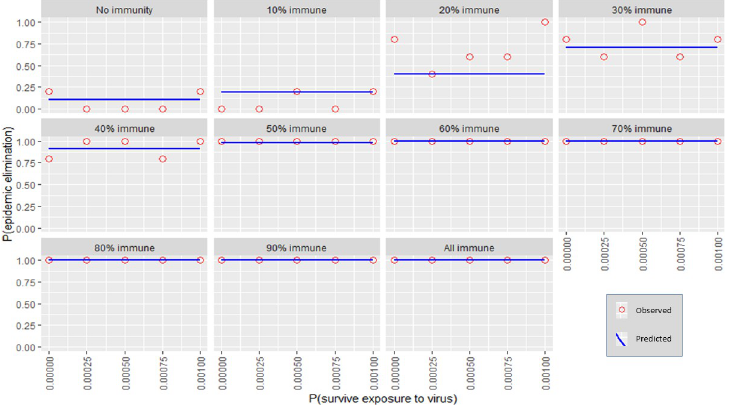
Fig 5. The response of P(elim.) to exposure survival probabilities at different herd immunities. The proportion of elimination events from the transmission model (red circles) and the prediction from the regression model (blue